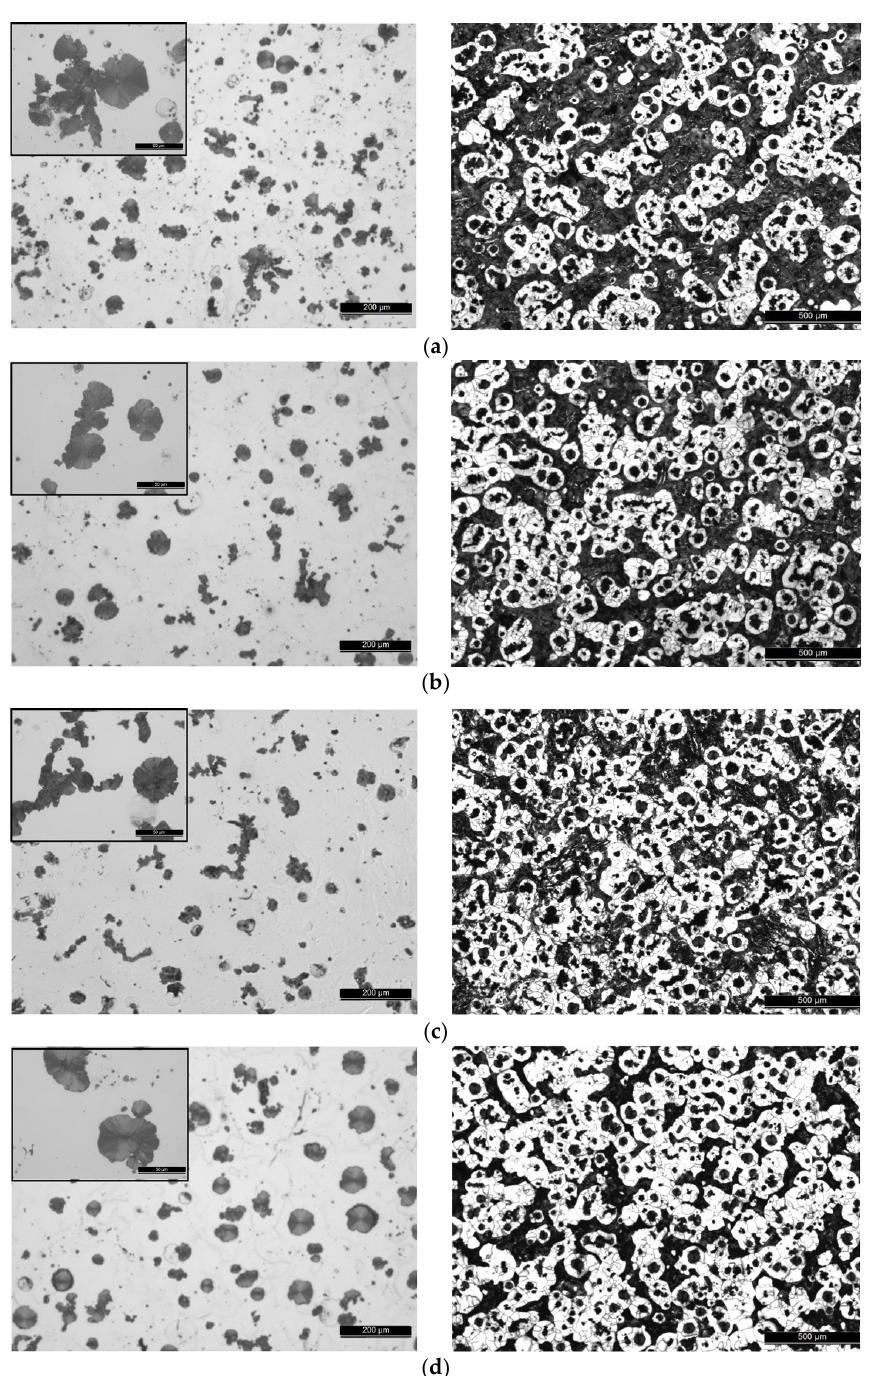
Figure 3. Optical microscopy images of samples unetched and etched of ( a ) noP Un , ( b ) CP Un , ( c ) LCP Un , and ( d ) TP Un samples.